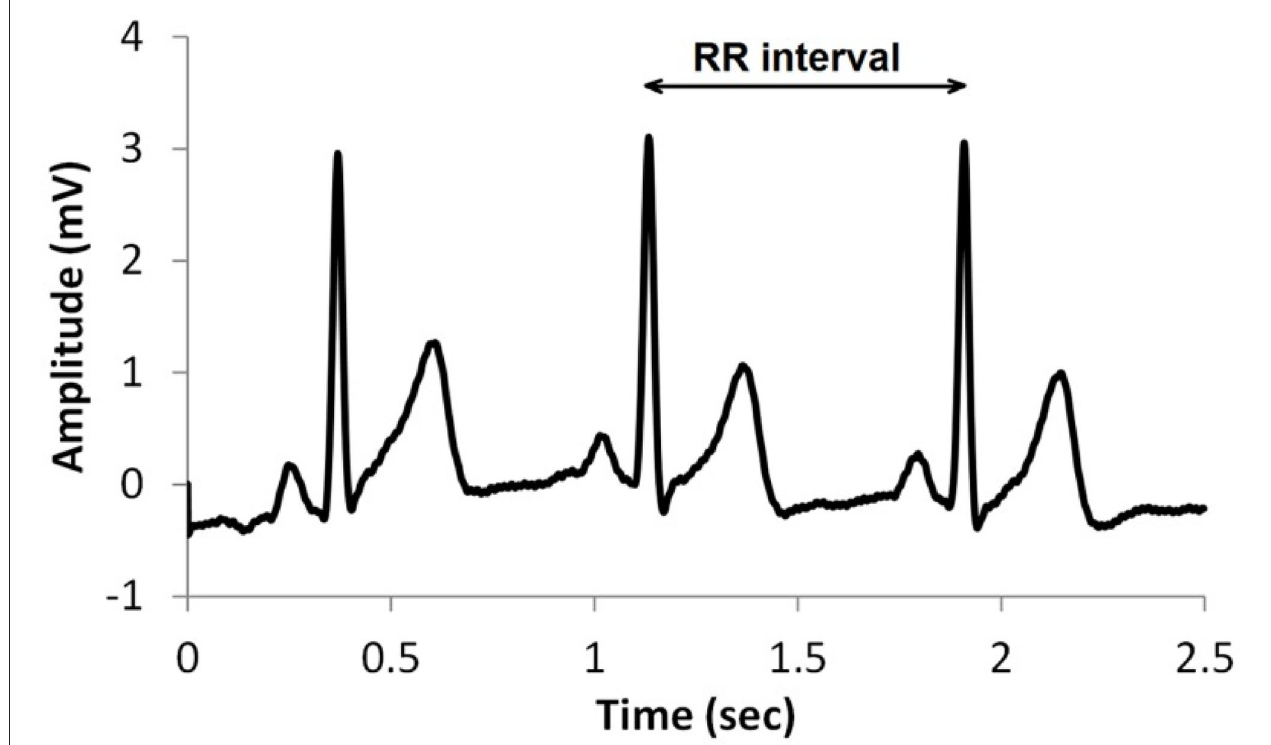
FIGURE 1 | ECG waveform with R-R intervals (Sahoo et al., 2011).